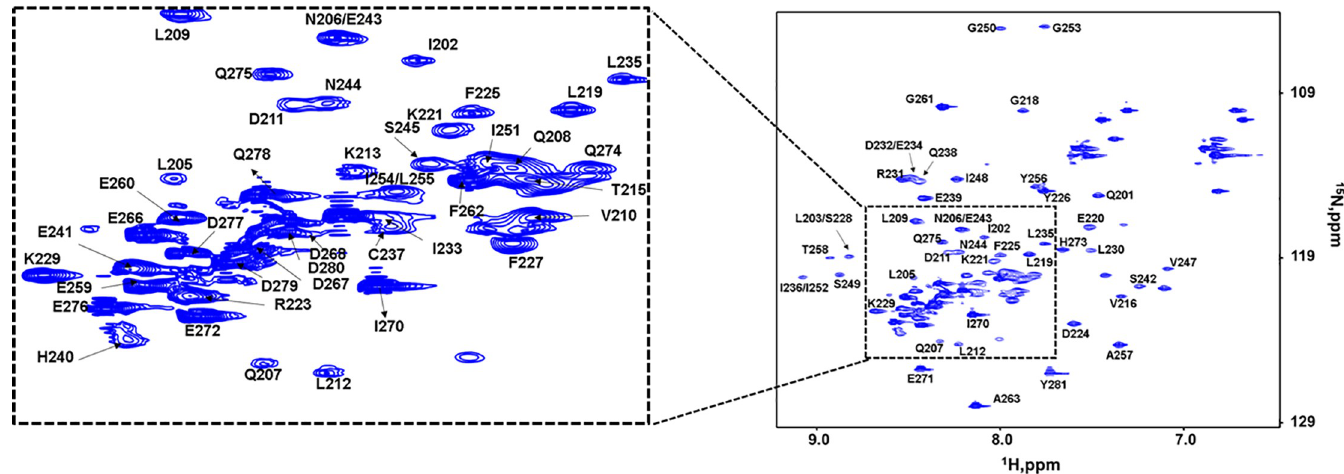
Fig 1. 1 H, 15 N HSQC spectra of 0.30 mM EB3 C-terminus (200–281). The spectra show assigned well-dispersed signals.